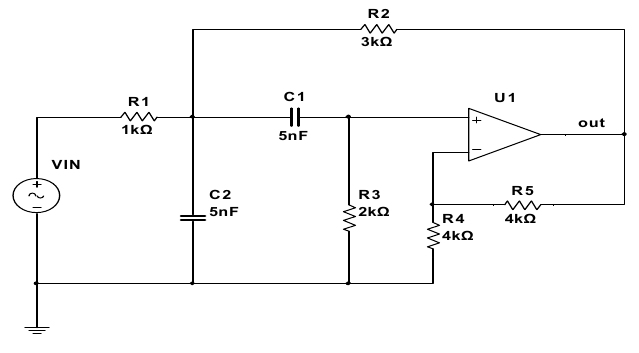
Figure 4. Sallen-key circuit diagram.